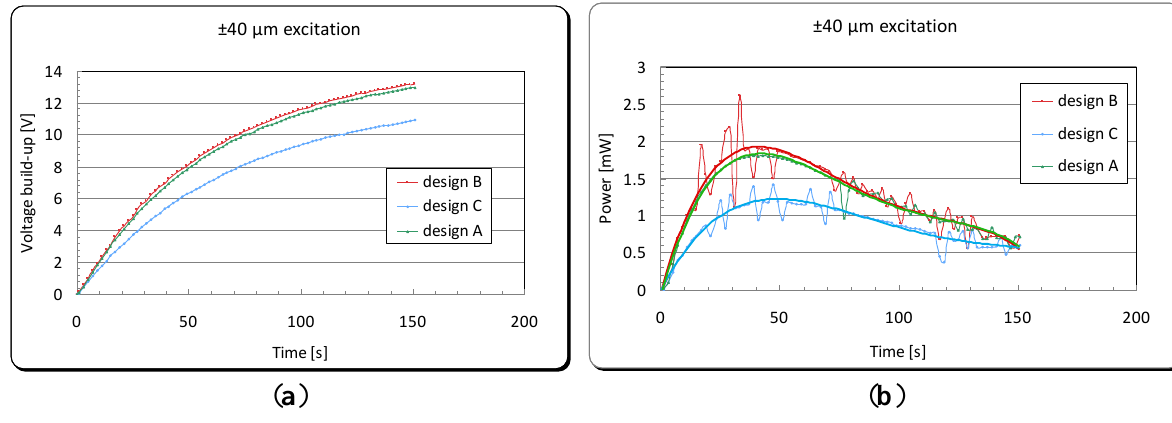
Figure 23. Output power spectrum of the energy harvester under ±0.5 g acceleration of excitation.